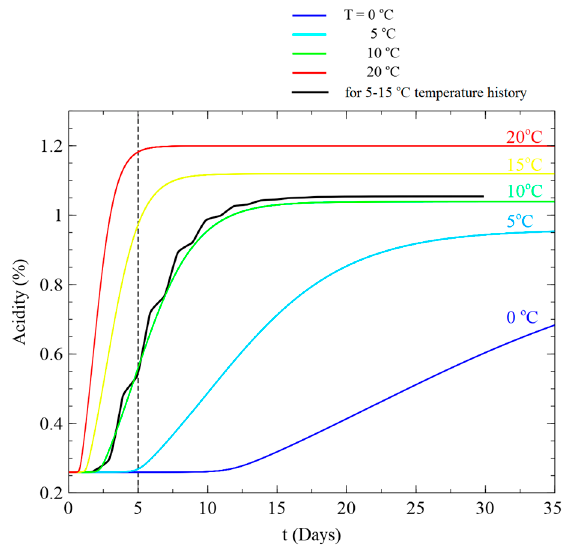
Figure 1. Example of estimation of mean kinetic temperature.